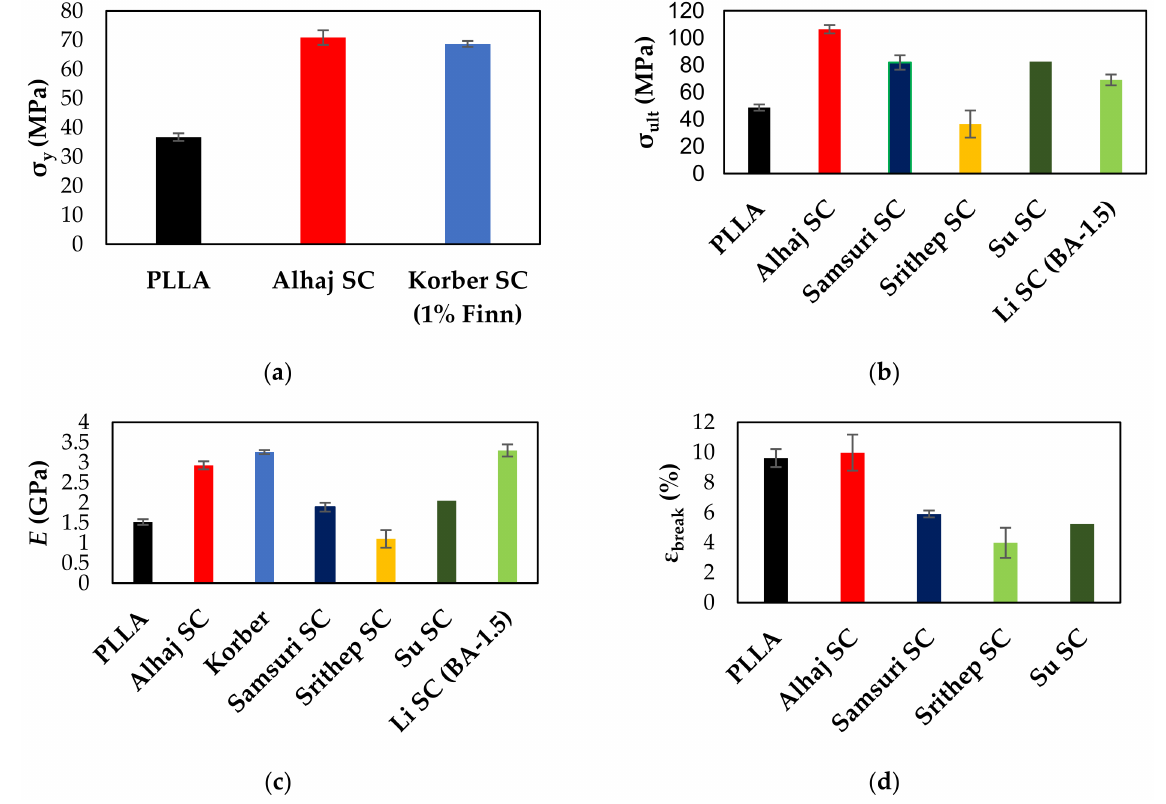
Figure 12. Comparison of the tensile behavior of extruded stereocomplex PLA vs. PLLA and the literature results. ( a ) Yield strength, ( b ) ultimate tensile strength, ( c ) elastic modulus, ( d ) elongation at